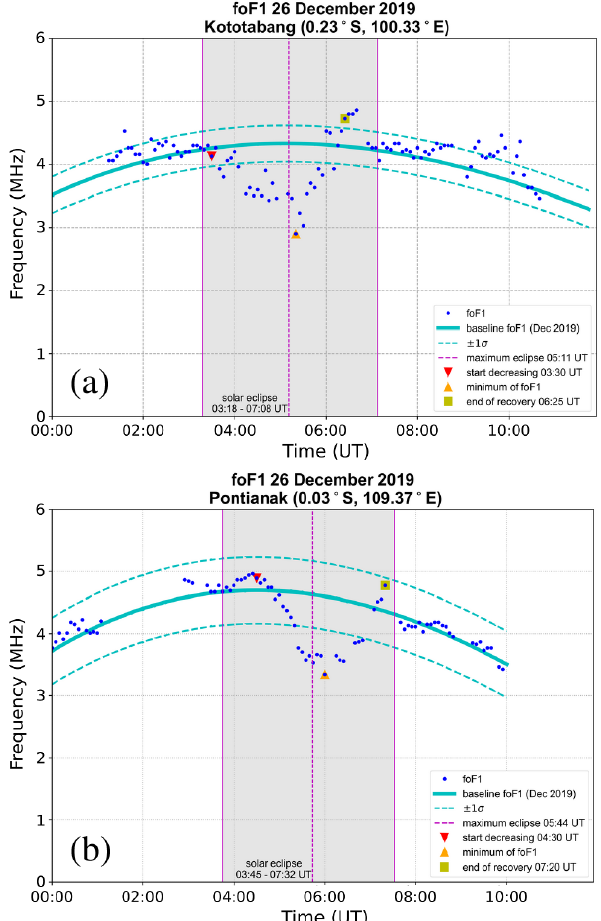
Figure 6. Time series plots of ionospheric F1-layer critical frequen- cies ( fo F1) from scaling of ionosonde measurements at (a) Kotota- bang and (b) Pontianak on 26 December 2019. Observation data are shown in blue, the baseline fo F1 level based on December 2019 averages is shown as cyan curves, and the solar eclipse period is indicated with gray